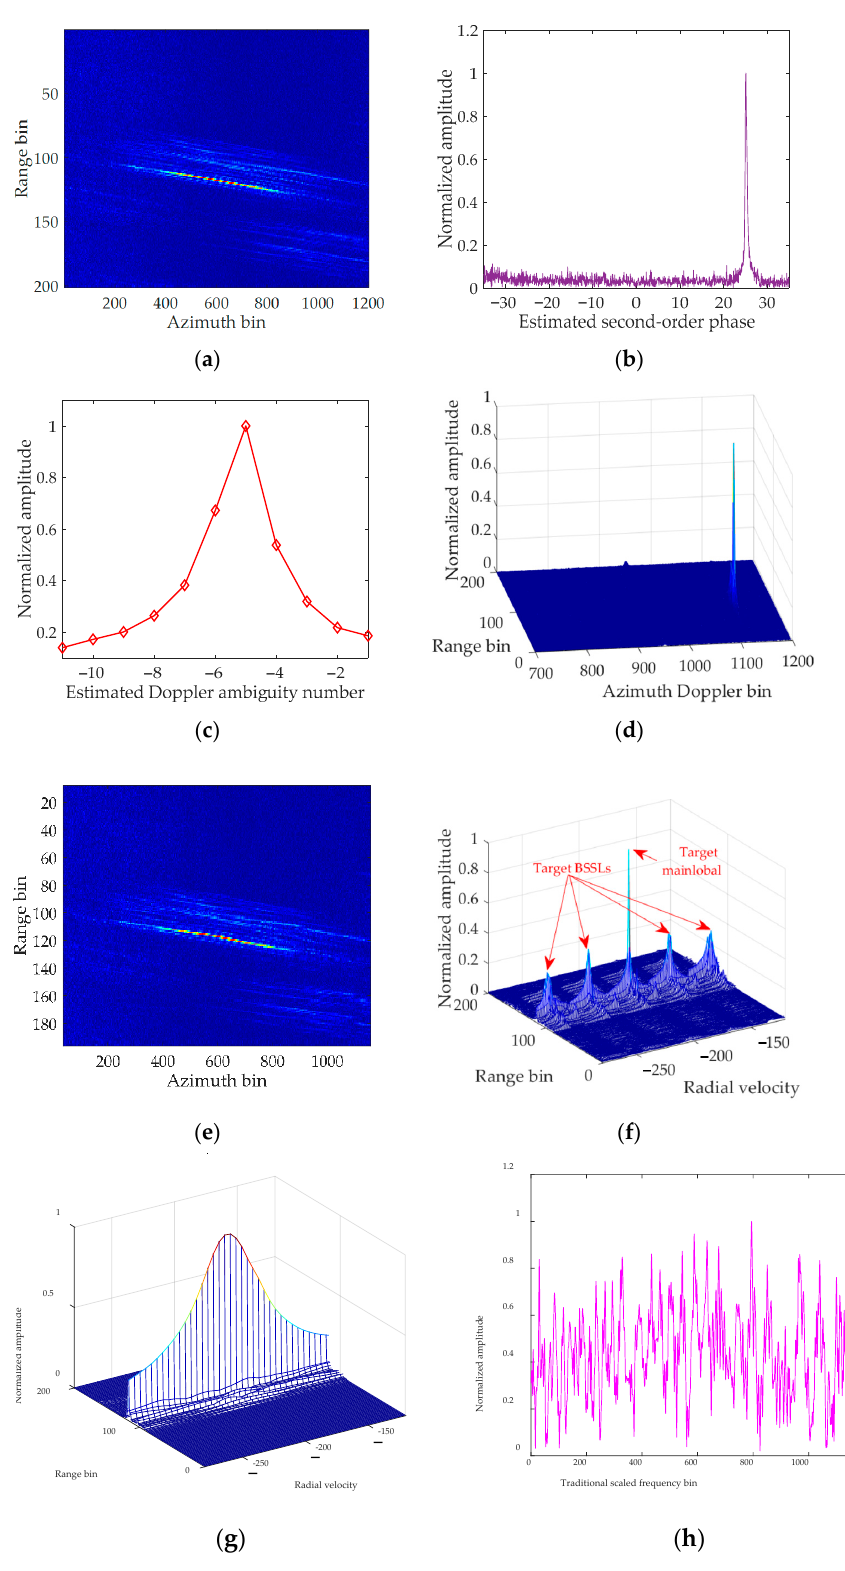
Figure 7. Spaceborne real data processing results: ( a ) Range compression result. ( b ) Estimated second-order phase coefficient by proposed method. ( c ) Estimated result of Doppler ambiguity number. ( d ) Final refocused result. ( e ) Result by direct keystone transform (KT). ( f ) Result by the method in [12]. ( g ) Result by the method in [13]. ( h ) Estimated second-order phase coefficient by the method in